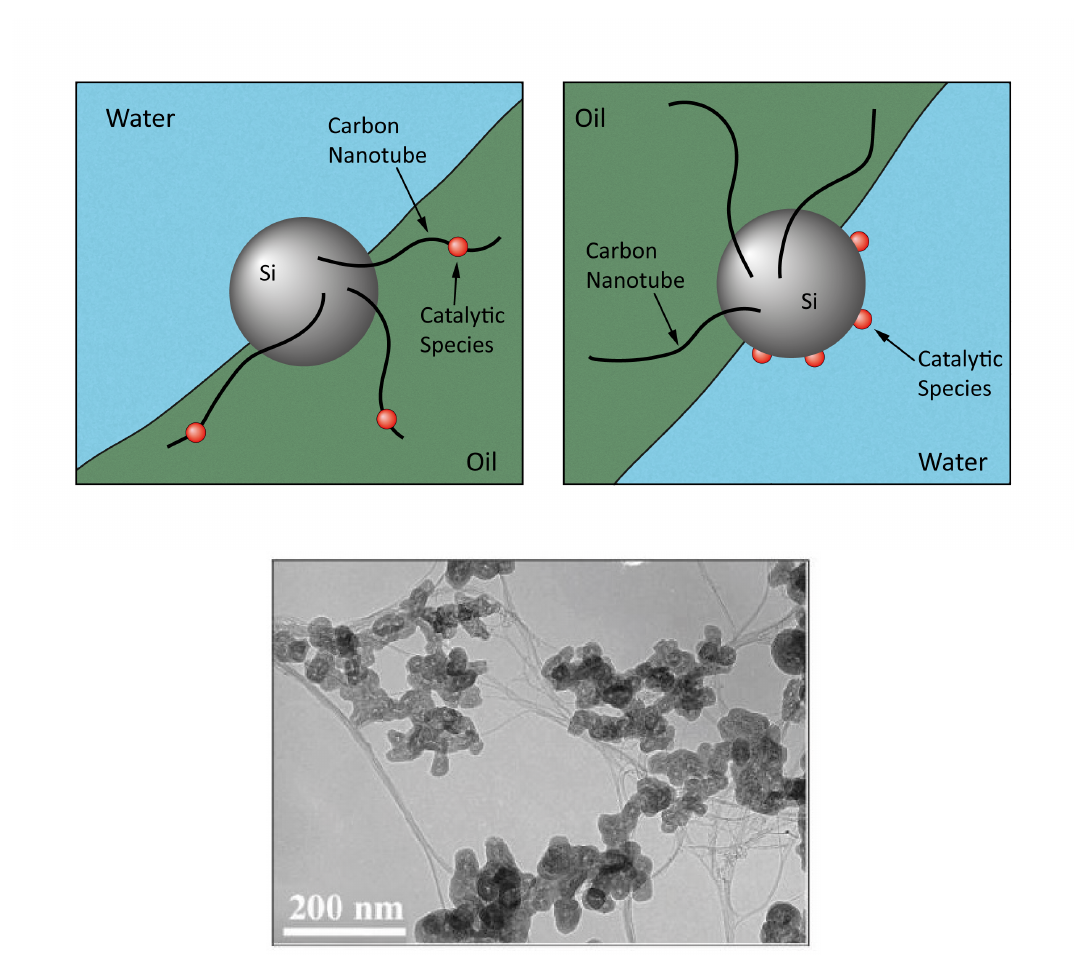
Figure 20. Scheme of nanohybrid particles carrying catalytic species in the oil and water phases ( top left and right , respectively). ( bottom ) TEM image of Si nanoparticles and SWCNTs (single-wall carbon nanotubes) after ultrasonication in water for 3 hours. Figures (top left and right) adapted from Ref. [107]; Figure (bottom) reproduced from Ref.